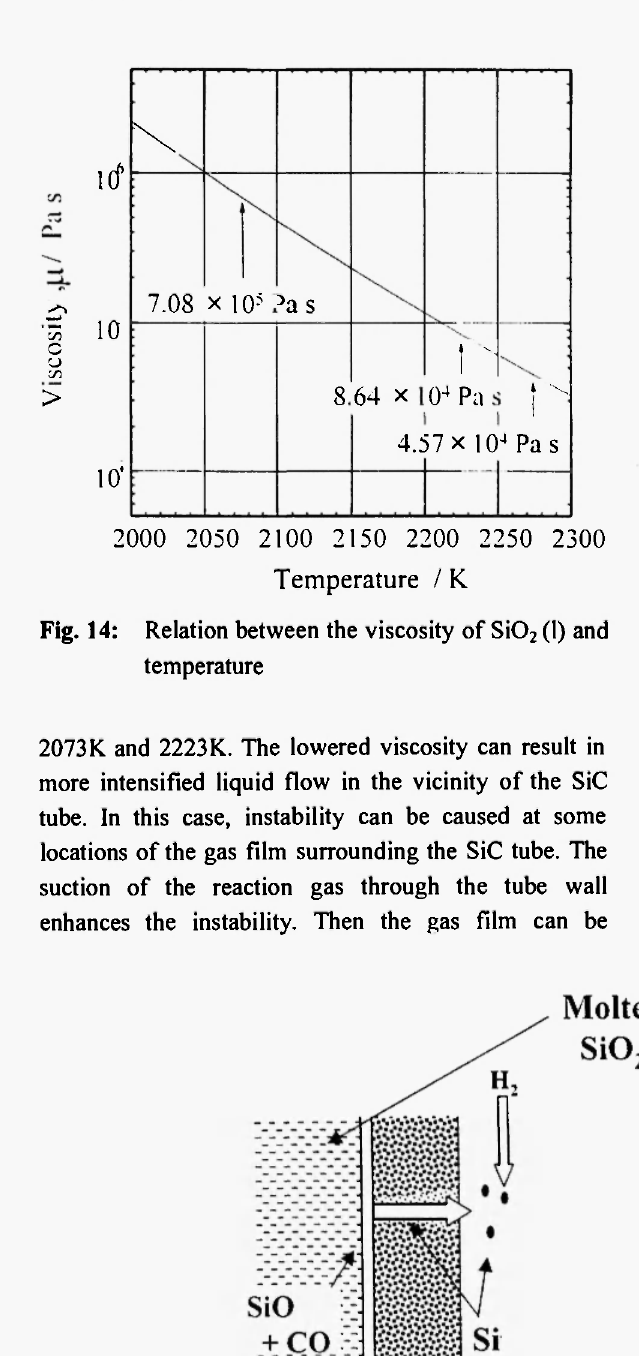
2073K and 2223K. The lowered viscosity can result in more intensified liquid flow in the vicinity of the SiC tube. In this case, instability can be caused at some locations of the gas film surrounding the SiC tube. The suction of the reaction gas through the tube wall enhances the instability. Then the gas film can